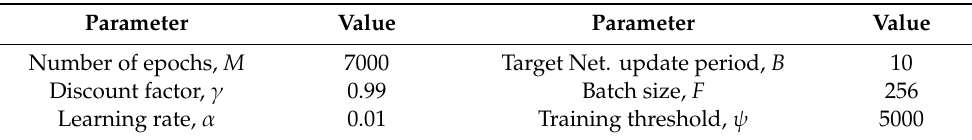
( b ) Figure 7. Cumulative rewards progress during the training process: ( a ) Convergence of cumulative rewards; ( b ) Convergence of total travel time. 4.2. Performance Evaluation The proposed DRL based algorithm is evaluated and compared with three conventional benchmarking strategies. The Benchmarking strategies are summarized in Table 5. •